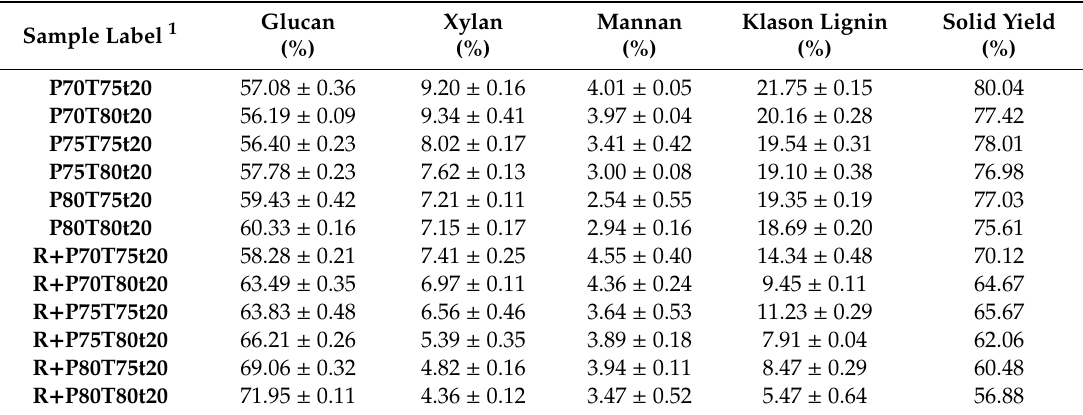
Table 2. Chemical composition and yields of water insoluble solids under di ff erent hydrotropic